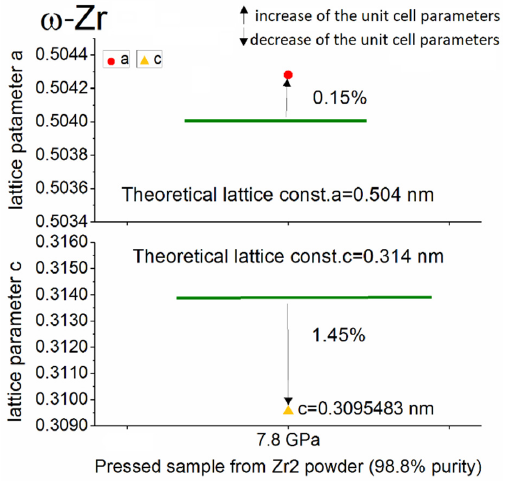
Figure 6. The change of the lattice parameters (in %) for the ω -Zr phase in the pressed sample compacted from Zr 2 powder (98.8% purity).